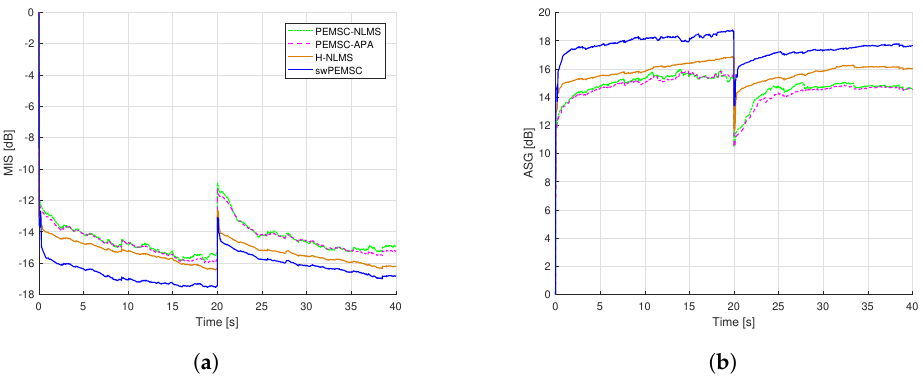
Figure 17. Compare performance of the proposed method with state-of-the art AFC methods using 5 segments of speech input, a sudden change of the feedback path from F 1 to F 2 after 20 s, MIS ( a ) and ASG ( b ) were average values computed over 5 segments of speech